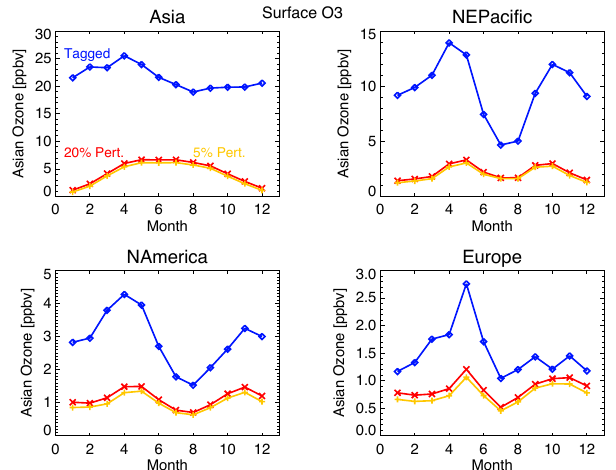
Fig. 10. Surface ozone attributed to Asian emissions based on tagged and perturbed NO x emissions, averaged over four receptor regions, as a function of month. The 20% perturbed contribution is 5 times (and the 5% perturbation case is 20 times) the difference between the standard simulation and a simulation with 80% NO x emissions in Asia. The receptor regions are Asia (0 ◦ –60 ◦ N, 60 ◦ – 180 ◦ E, same as emissions), NE Pacific (30 ◦ –55 ◦ N, 190 ◦ –235 ◦ E), N. America (15 ◦ –55 ◦ N, 235 ◦ –300 ◦ E) and Europe (30 ◦ –70 ◦ N, 0 ◦ –45 ◦